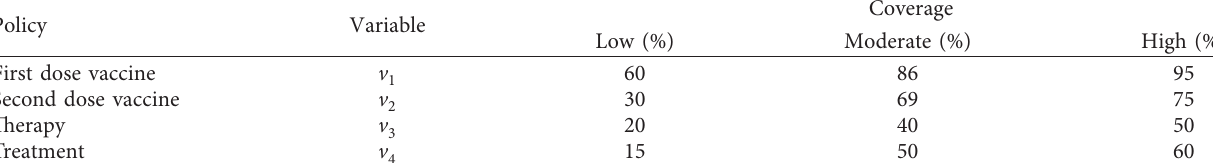
Figure 4: (a) Optimal controls and (b) adjoin variables. Table 5: Control